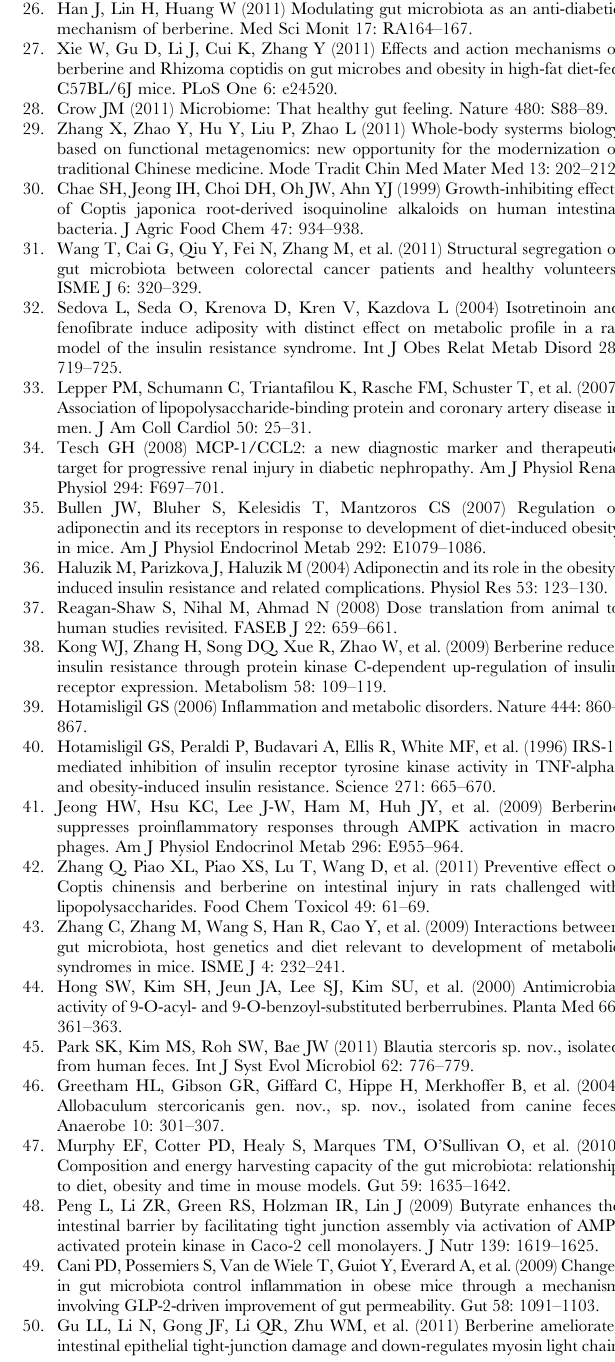
Table S3 Univariate comparisons of the 268 key OTUs identified by